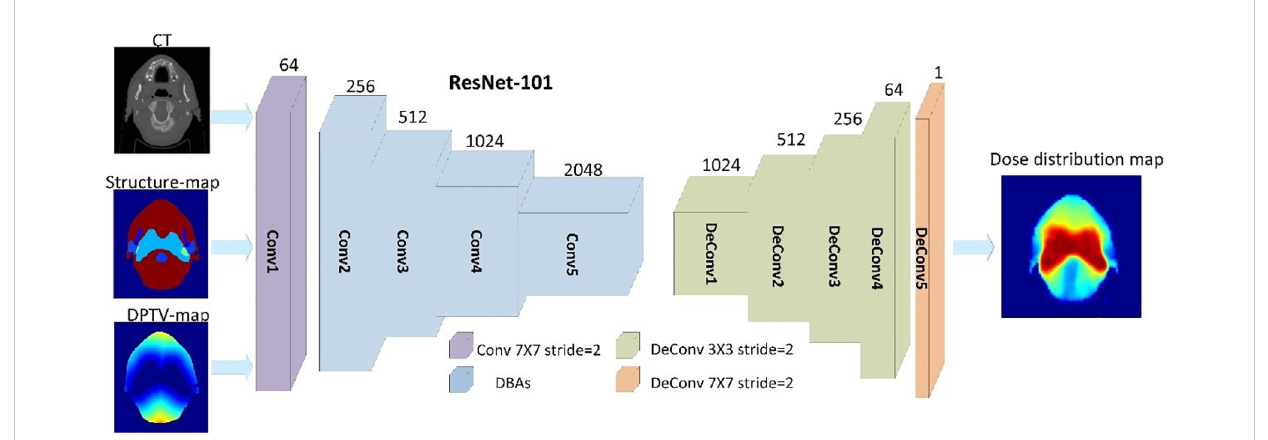
FIGURE 1 Training work fl ow based on 101 with three input channels (CT, structure maps, and DPTV maps) of the COM